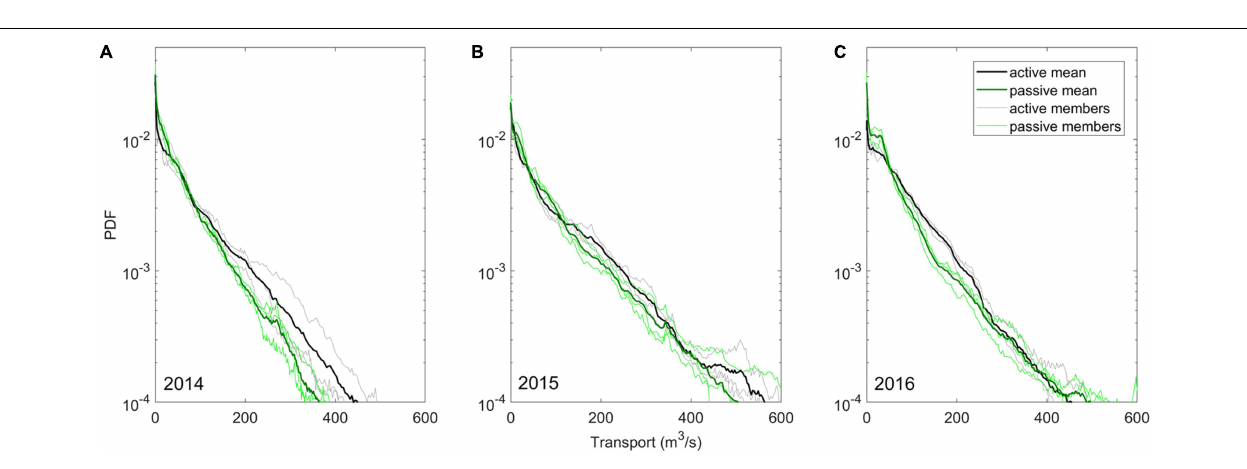
FIGURE 10 | Probability density functions (PDFs) of active and passive transport ensembles for August of 2014 (A) , 2015 (B) , and 2016 (C)